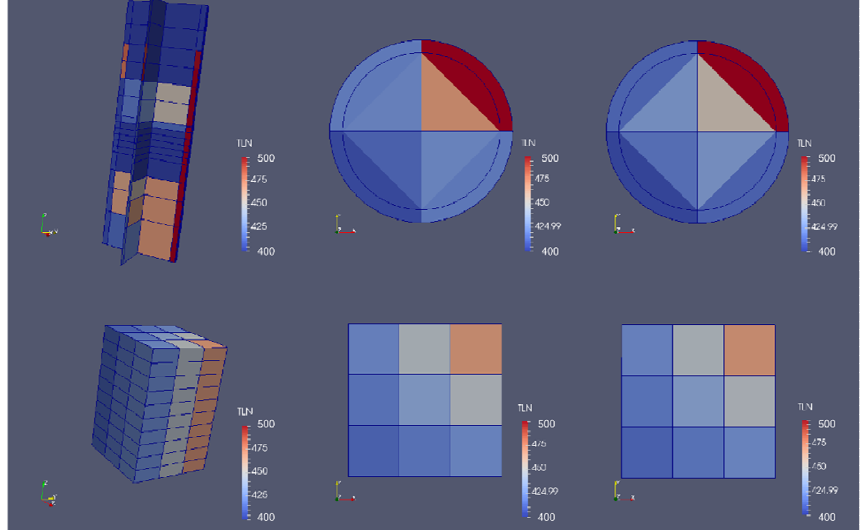
Figure 12. The coolant temperature distributions in the CY-V and CA-V (from left to right, from top to bottom: 3D field/2D field at the core inlet/2D field at the core outlet of CY-V, 3D field/2D field at the core inlet/2D field at the core outlet of CA-V).